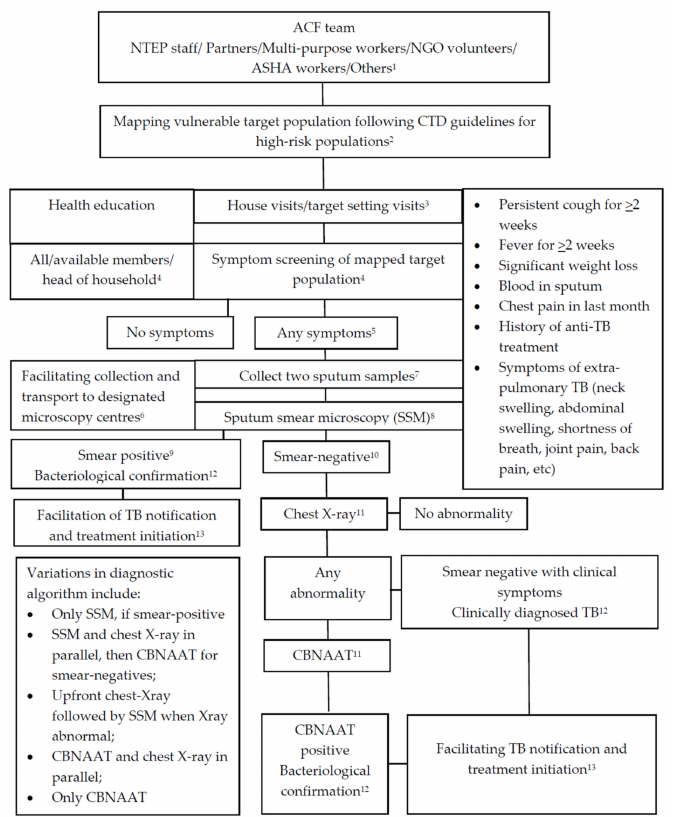
Figure 1. Screening flow chart for active case finding (ACF) in campaign mode under the National Tuberculosis Elimination Programme (NTEP) with intervention points to facilitate case finding and treatment initiation. ASHA: Accredited social health activist; CBNAAT: Cartridge-based nucleic acid amplification test; CTD: Central TB division. Facilitators : 1 Resources, training,